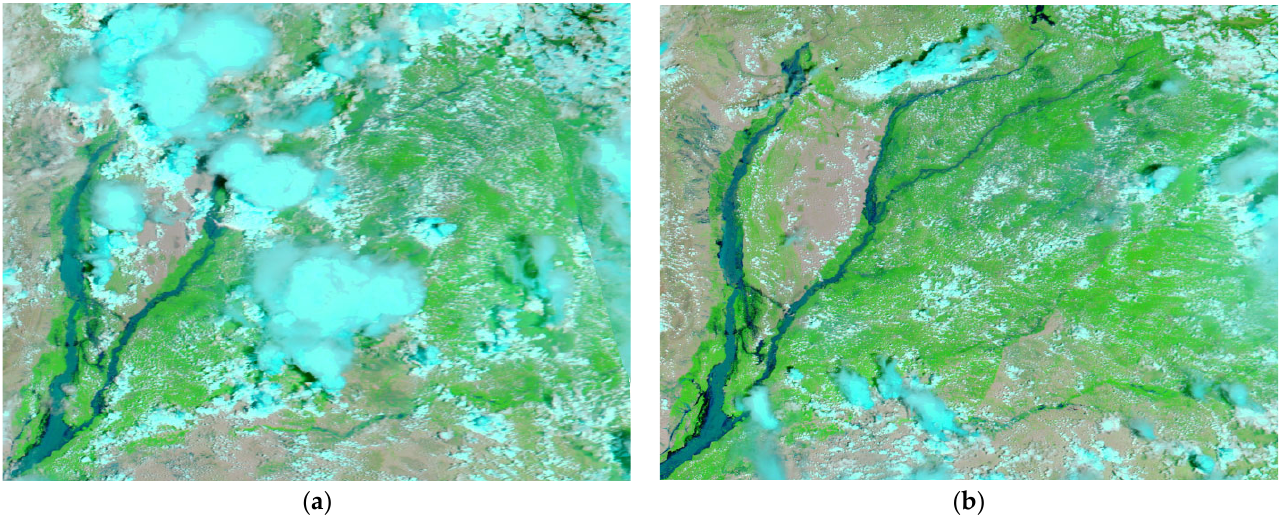
Figure 5. Flash flood from monsoon rains 2010 lasting ( a ) at D ‐ 227, and ( b ) at D ‐ 229, crashing down from the Himalayan Mountain Range (northern Pakistan), and muddy water swept over the south of the plain.